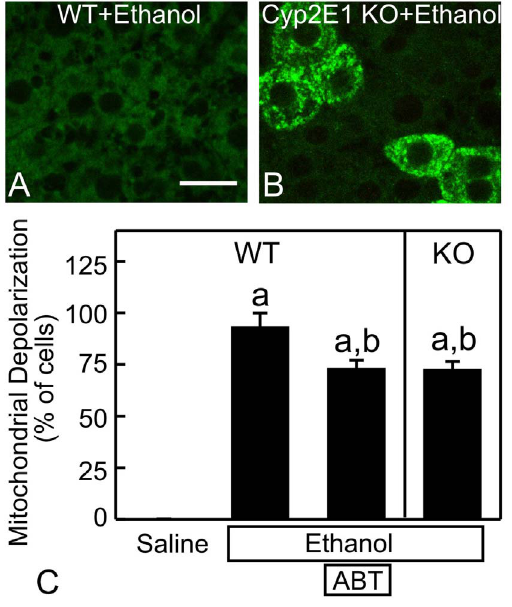
Figure 6. Role of cytochrome P450-dependent ethanol metab- olism in mitochondrial depolarization. Wild-type (WT) ( A ) and Cyp2E1 knock-out (KO) ( B ) mice were gavaged with ethanol (6 g/kg). Rh123 fluorescence was detected after 6 h. Some WT mice were pretreated with aminobenzotriazole (ABT, 100 mg/kg, i.p. ), a cyto- chrome P450 inhibitor, 30 min prior to ethanol. In C , mitochondrial depolarization as a percentage of all hepatocytes is plotted. Values are means 6 SEM (n=4 per group). a, p , 0.05 vs WT with saline; b, p , 0.05 vs WT with ethanol. Bars are 10 m m.